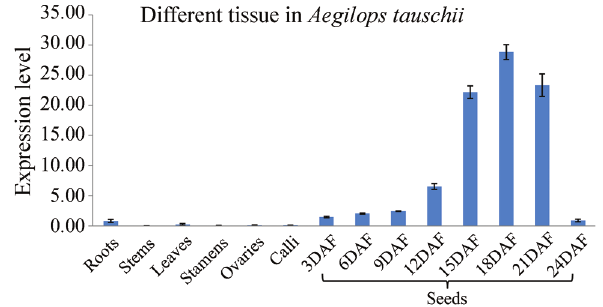
Figure 5 - Real-time PCR analysis of WOX2 transcript levels in different tissues of Ae. tauschii and seed growth stages. Expression was normalized to an actin